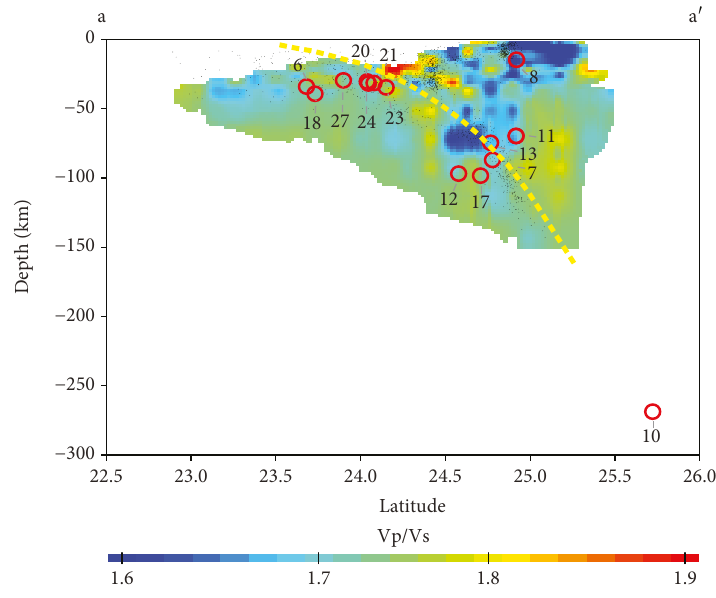
and Δ T , respectively, showing that a radon anomaly occurs earlier than Gamma Radon